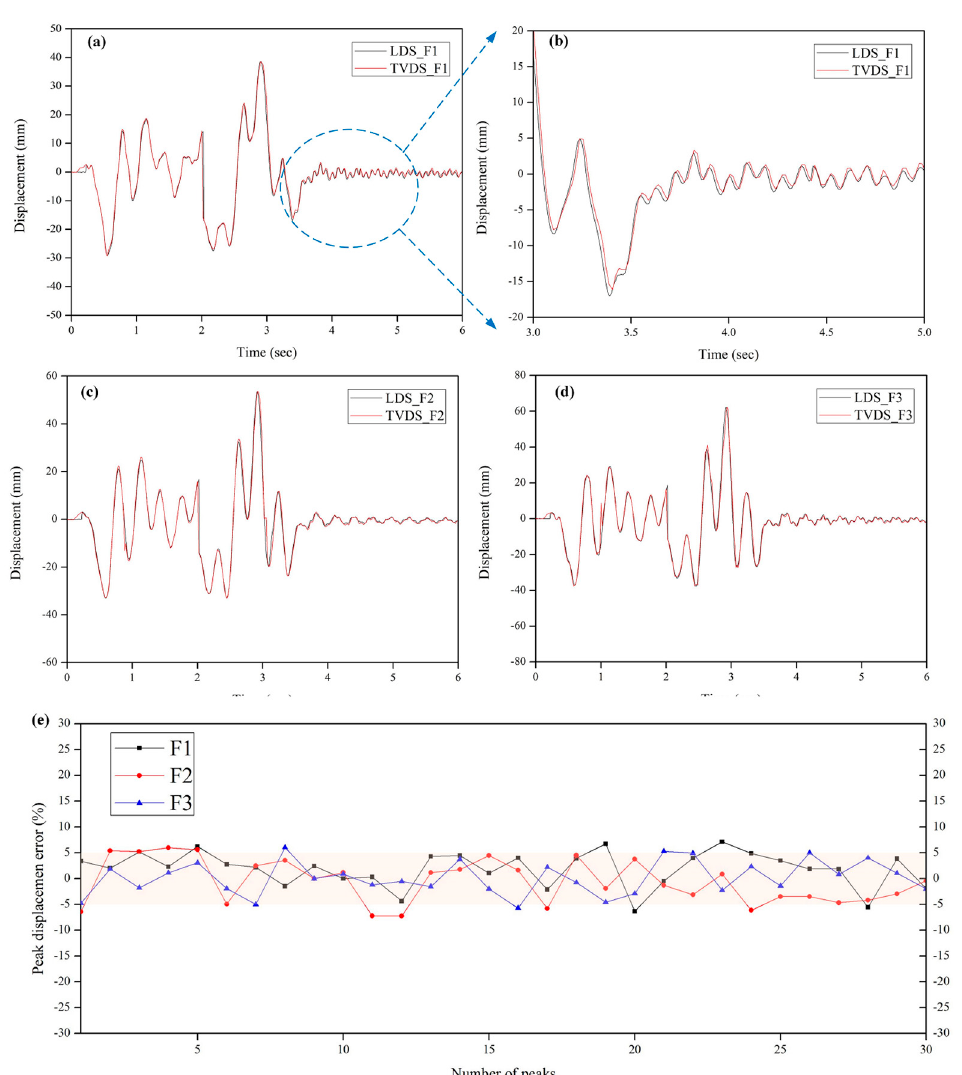
Figure 10. Comparison of dynamic displacement data between VDS and LDS according to the floor level. ( a ) 1st floor; ( b ) detail comparison of the 1st floor; ( c ) 2nd floor; ( d ) 3rd floor; ( e ) peak displacement error.